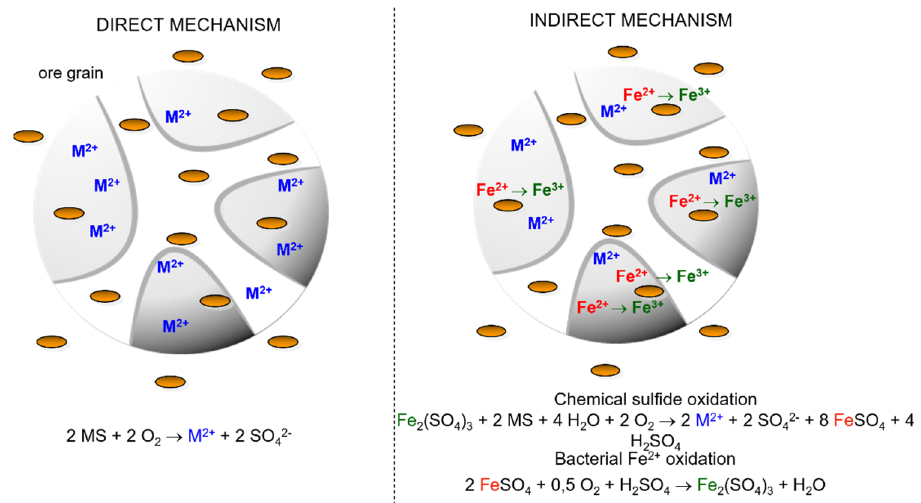
Figure 3. Differences between direct and indirect bioleaching mechanisms (M-metal) .